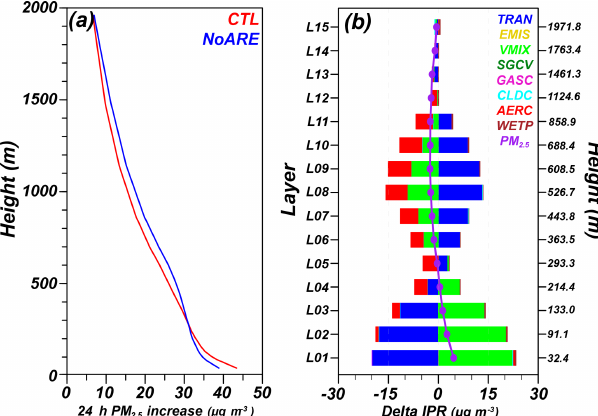
Figure 12. (a) Vertical profiles of the 24h increases in PM 2 . 5 concentrations (23:00 minus 00:00LST) averaged over Beijing– Tianjin–Hebei during Stage 1 in the CTL and NoARE cases. (b) Vertical profiles of the differences in the 24h PM 2 . 5 increases caused by the aerosol radiative effect (CTL minus NoARE, purple dotted line), and the contributions of each physical/chemical pro- cess (colored